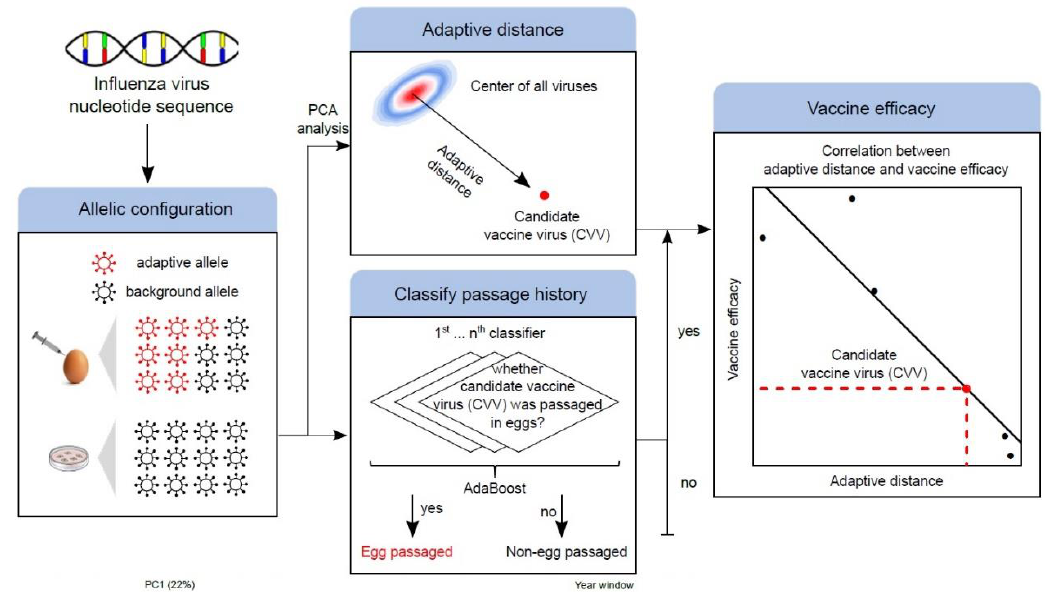
Figure 2. Schematic workflow of MADE. For any candidate vaccine virus (CVV), enrichment scores (ES) of all the alleles (amino acids) at the 17 positively selected HA1 codons were computed. These high dimensional vectors calculated at the 17 codons serve as allelic barcodes for each strain. Principal component analysis of the ES scores for all existing sequences was conducted, and the adaptive distance (AD) for the CVV was computed. Subsequently, MADE predicted the VE ad of the input CVV based on the linear relationship between AD and vaccine effectiveness (VE). In addition, a machine learning algorithm can be applied to classify whether the input sequence with unknown passage history has been grown in embryonated eggs or other passage mediums (e.g., MDCK).